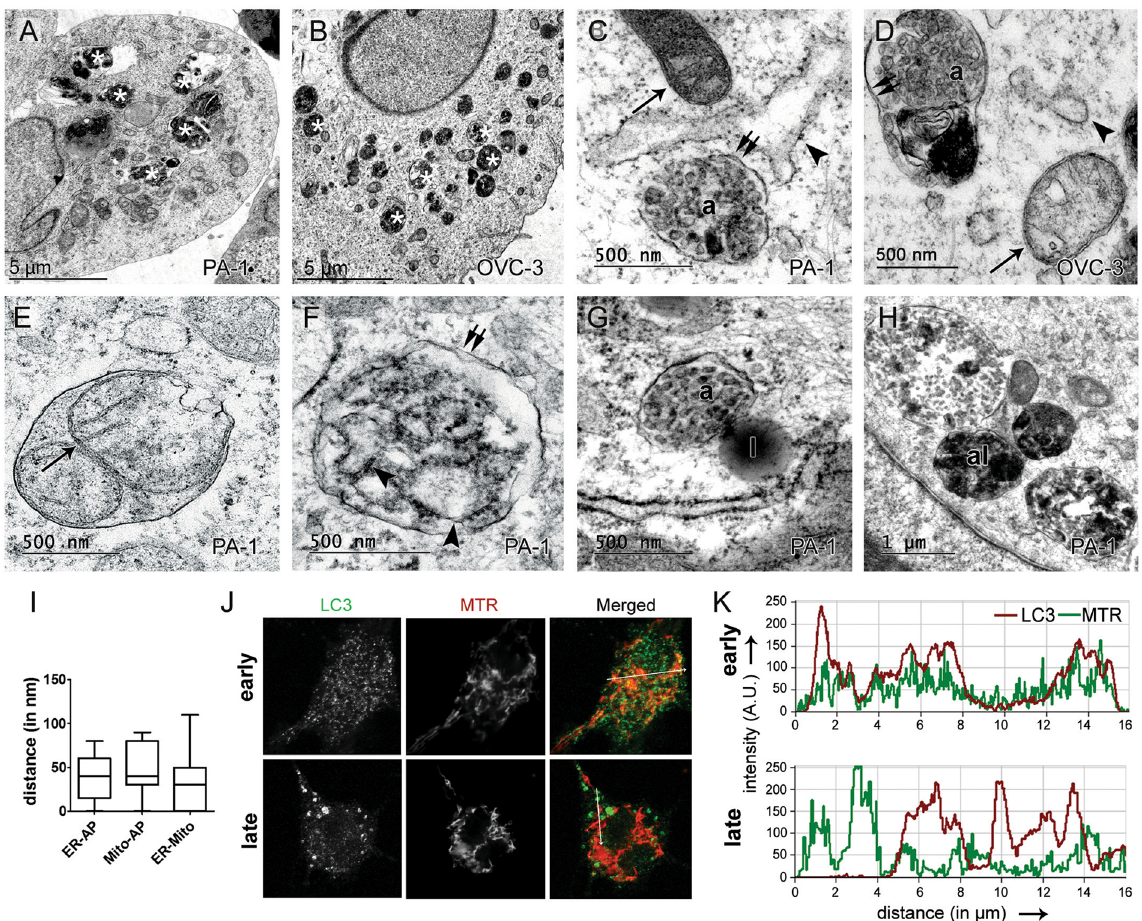
Figure 2. Involvement of ER and mitochondria in ORM-induced autophagy. Representative transmission electron micrographs of ( A ) PA-1 and ( B ) OVCAR-3 cells post-treatment with IC 50 dose of ORM show numerous electron-dense autophagosomes (asterisks). ( C ) PA-1, and ( D ) OVCAR-3 cells early stages post-treatment ( < 3 h) showing a close association between ER (arrowheads), mitochondria (arrows) and autophagosomes [a]. ( E ) Engulfment of mitochondria, and ( F ) rough ER by autophagosomes observed in PA-1 cells. ( G ) Fusion of autophagosome with electron-dense lysosome [l] and, ( H ) formation of autolysosomes [al] in PA-1. ( I ) Calculation of mean distance between ER, mitochondria and autophagosomes in early stages of treatment ( < 3 h). ( J ) PA-1 cells treated with ORM for 3 h (early) and 24 h (late) were immunostained with LC3 and counterstained with Mitotracker Red (MTR). ( K ) Co-localization of MTR and LC3 signal observed in early stages (drag-in-image) while absent in late stages. Double arrows = double membraned